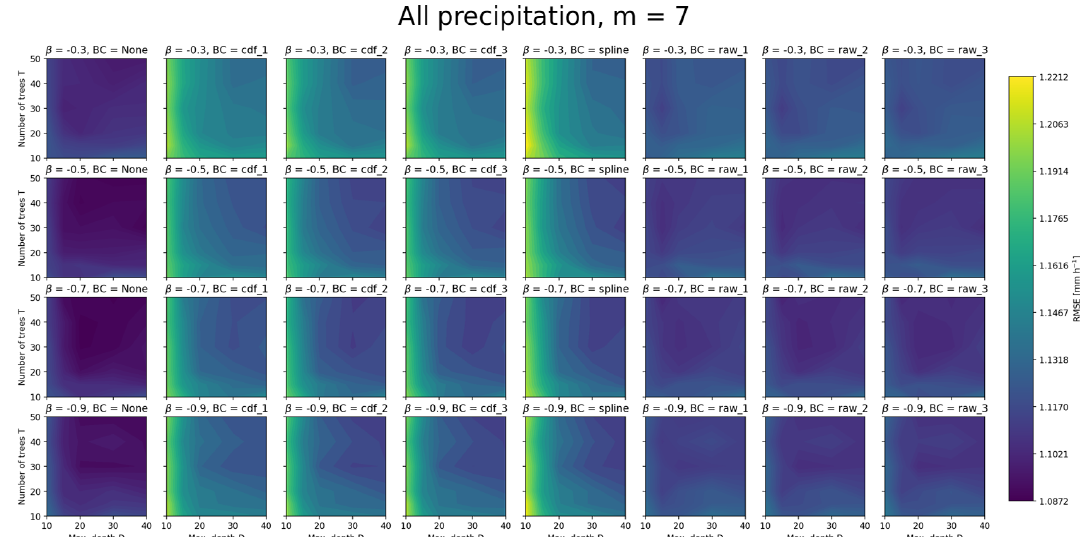
Figure B1. Overall RMSEs for all observations as a function of number of trees, maximum depth, β parameter and bias-correction method. The maximum number of randomly chosen variables at each split is here set to seven.